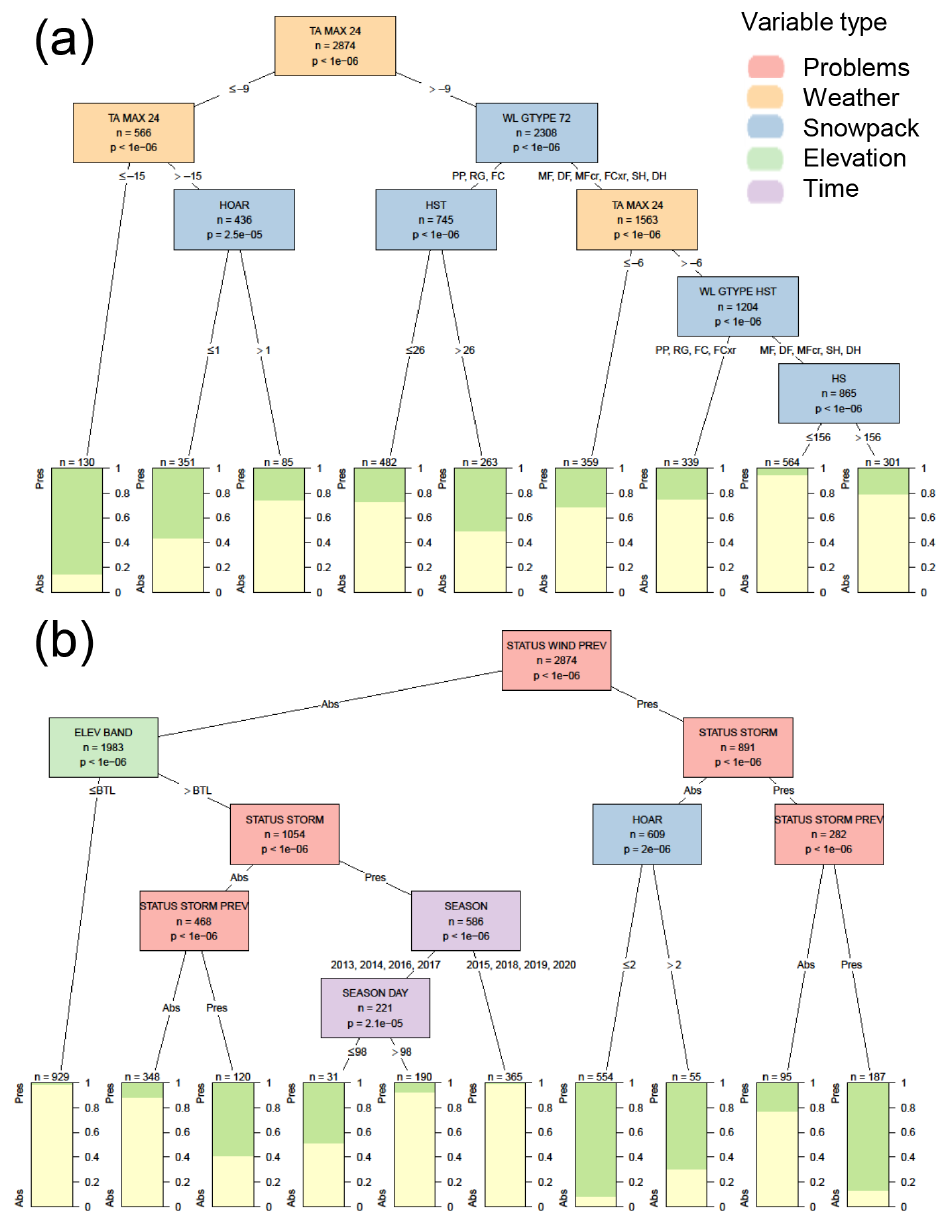
Figure C1. Conditional inference tree for the presence or absence (Pres/Abs) of wind slab avalanche problems (a) based on weather and snowpack variables and (b) including additional contextual variables about the hazard assessment. Variables appearing in the tree include maximum air temperature over the past 24h in ◦ C (TA MAX 24), the size of surface hoar on the surface in mm (HOAR), the grain type beneath snow deposited in the past 72h (WL GTYPE 72), the height of new snow since the last snow-free day (SLAB THICKNESS HST), the grain type beneath snow deposited since the last snow-free day (WL GTYPE HST), the total snow height in cm (HS), the presence or absence of a wind slab problem the previous day (STATUS WIND PREV), the elevation band (ELEV BAND) relative to below the treeline (BTL), the presence or absence of a storm slab problem the same or previous day (STATUS STORM and STATUS STORM PREV), the specific season (SEASON), and the number of days since 1 October (SEASON DAY). Terminal nodes show the proportion of cases with wind slab problems present (green) and absent